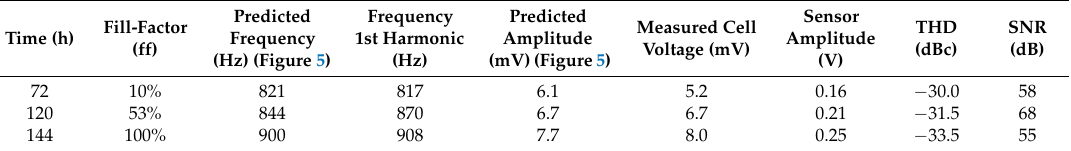
Figure 11. Waveforms (up) for the selected time points and the corresponding frequency spectrums (down) (W6, 2500 N2A seeded cells in t = 0). Table 1. Experimental values acquired from the system (W6, 2500 N2A seeded cells in t = 0). Frequencies, amplitudes, measured voltage, sensor amplitude, total harmonic distortion (THD) and signal-to-noise ratio (SNR).